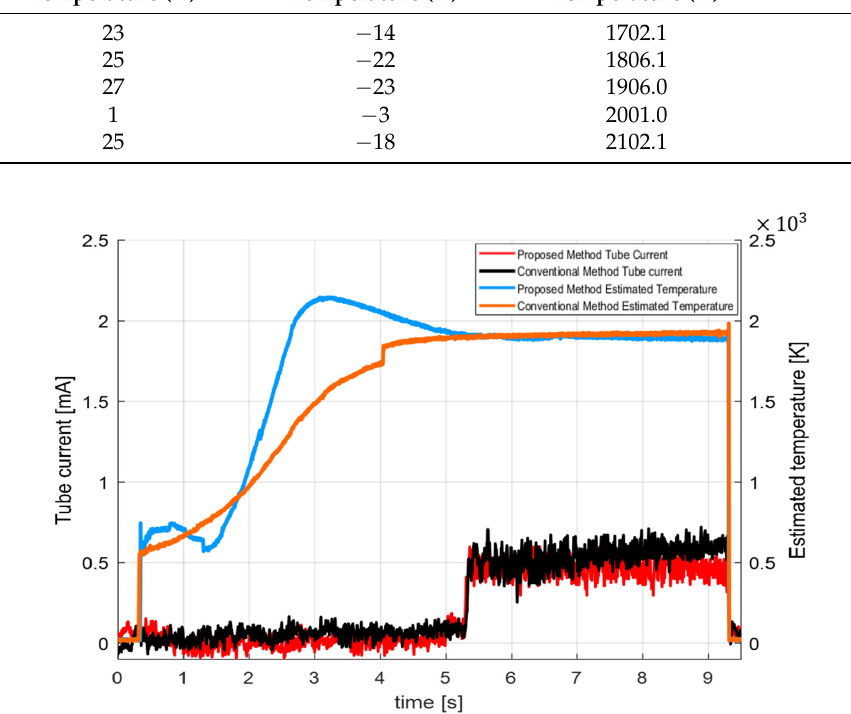
Figure 10. Comparison of the conventional and proposed methods at 1900 K.